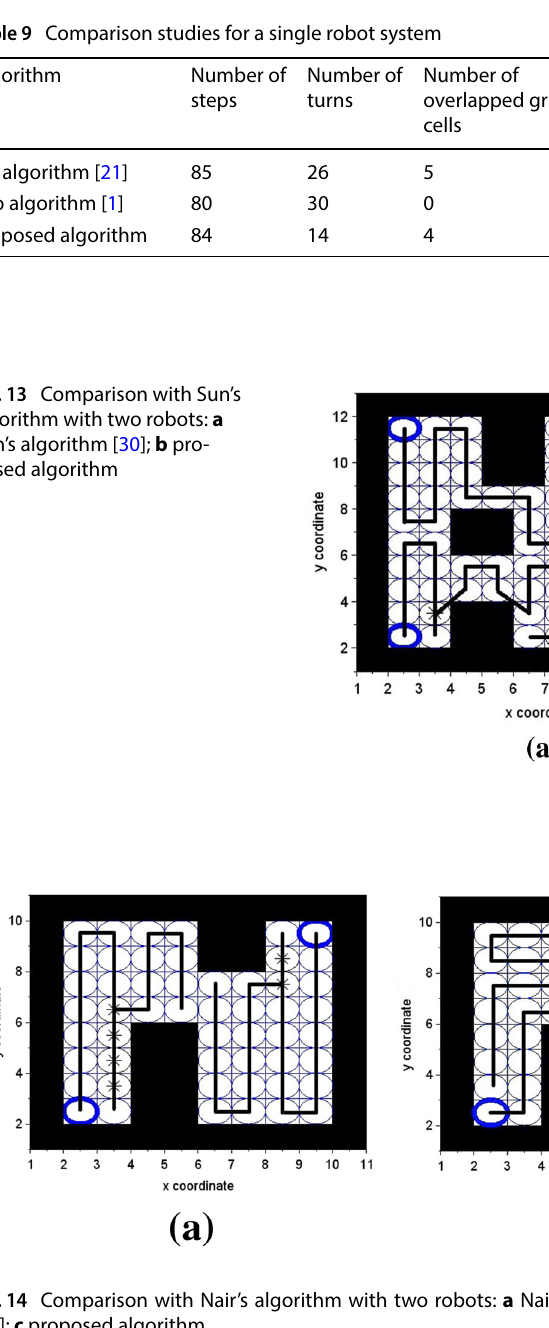
Fig. 14 Comparison with Nair’s algorithm with two robots: a Nair’s algorithm with BDC strategy [32]; b Nair’s algorithm with STC strategy [32]; c proposed